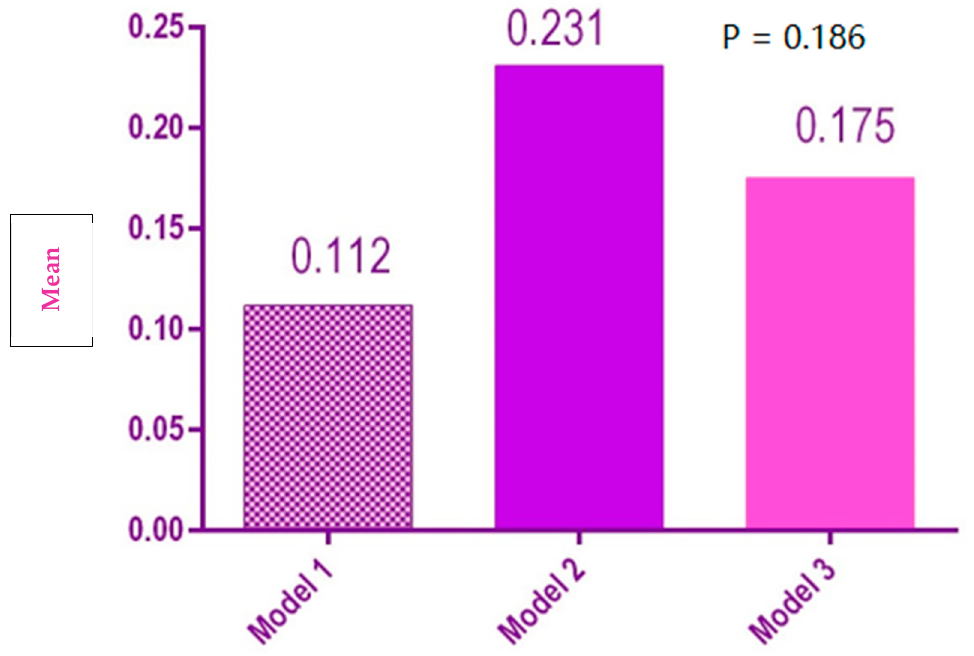
Figure 12. Statistical results of the external distances of the dental arch for the 3 models.